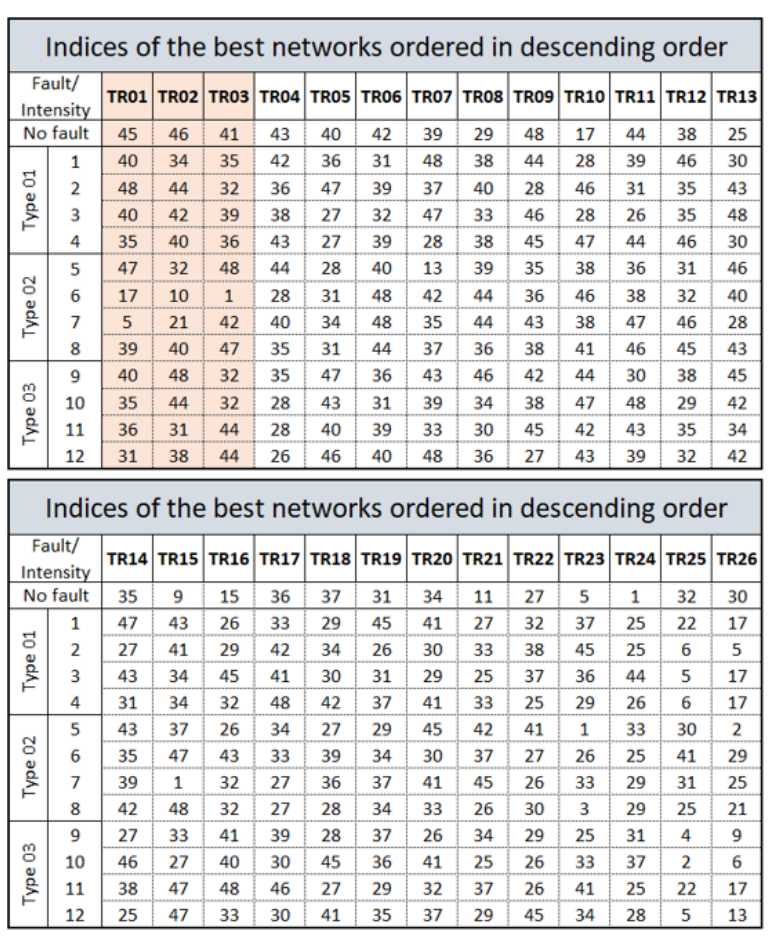
Figure 9. The 26 best networks with the best training performances, in descending order. The indexes in Figure 9 must be selected from a set of Cartesian Product, on the chosen properties of the neural network architecture. Each number represents an index that names the neural network itself to detect each type of fault with its due intensity. The existing possibilities and the indexes that identify them are shown in Figure 10. Thus, it is still possible to perform other TR from the total possible configurations of NARX networks.